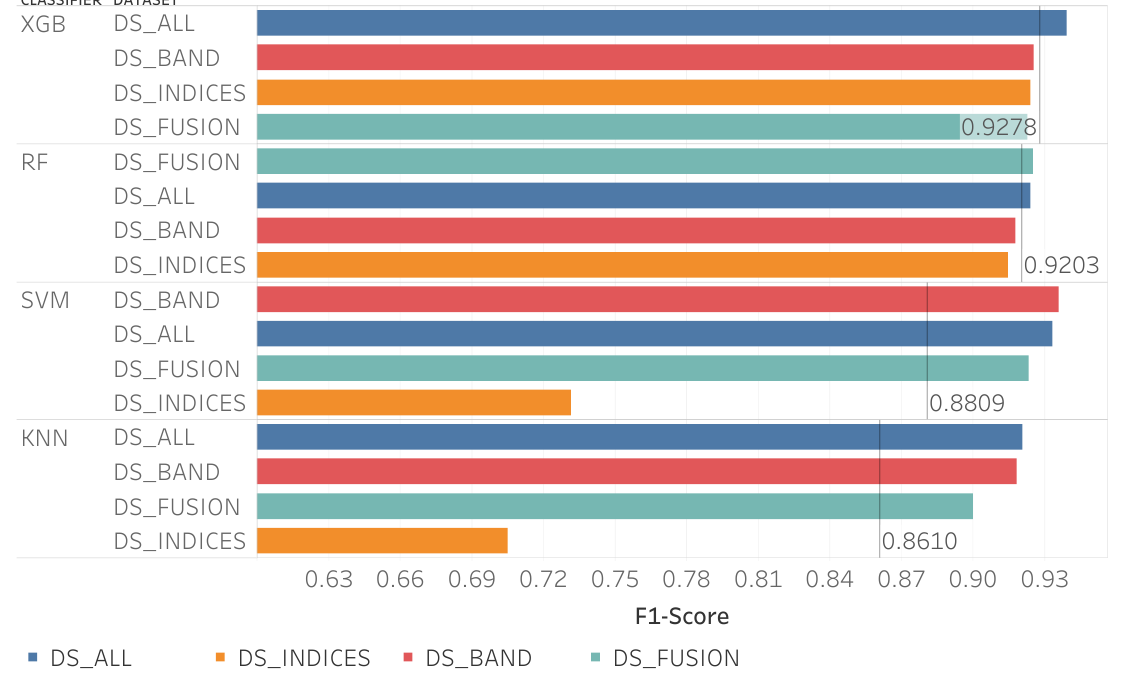
Figure 11. F1-score value for all algorithms and data sets using just Sentinel-2 data.